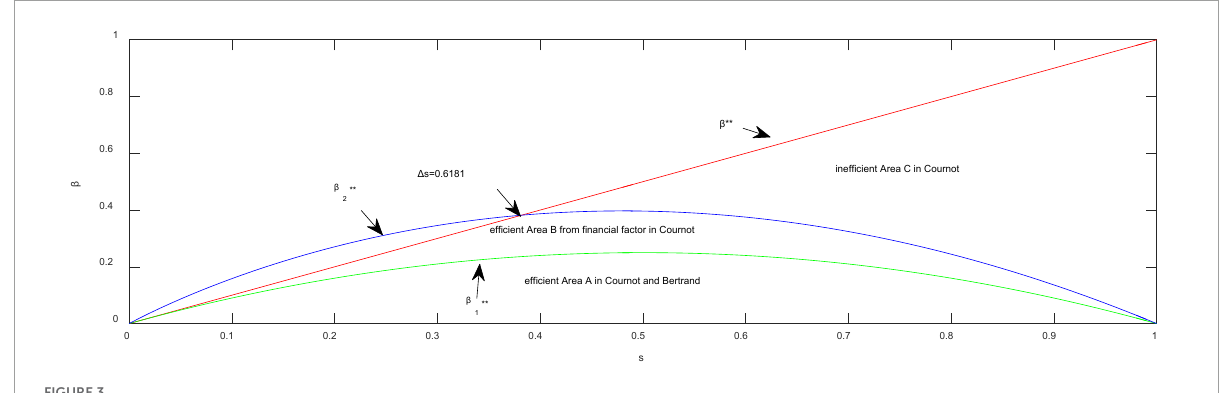
FIGURE3 Changes of efficient boundaries both in Cournot and Bertrand. **Thresholds of network